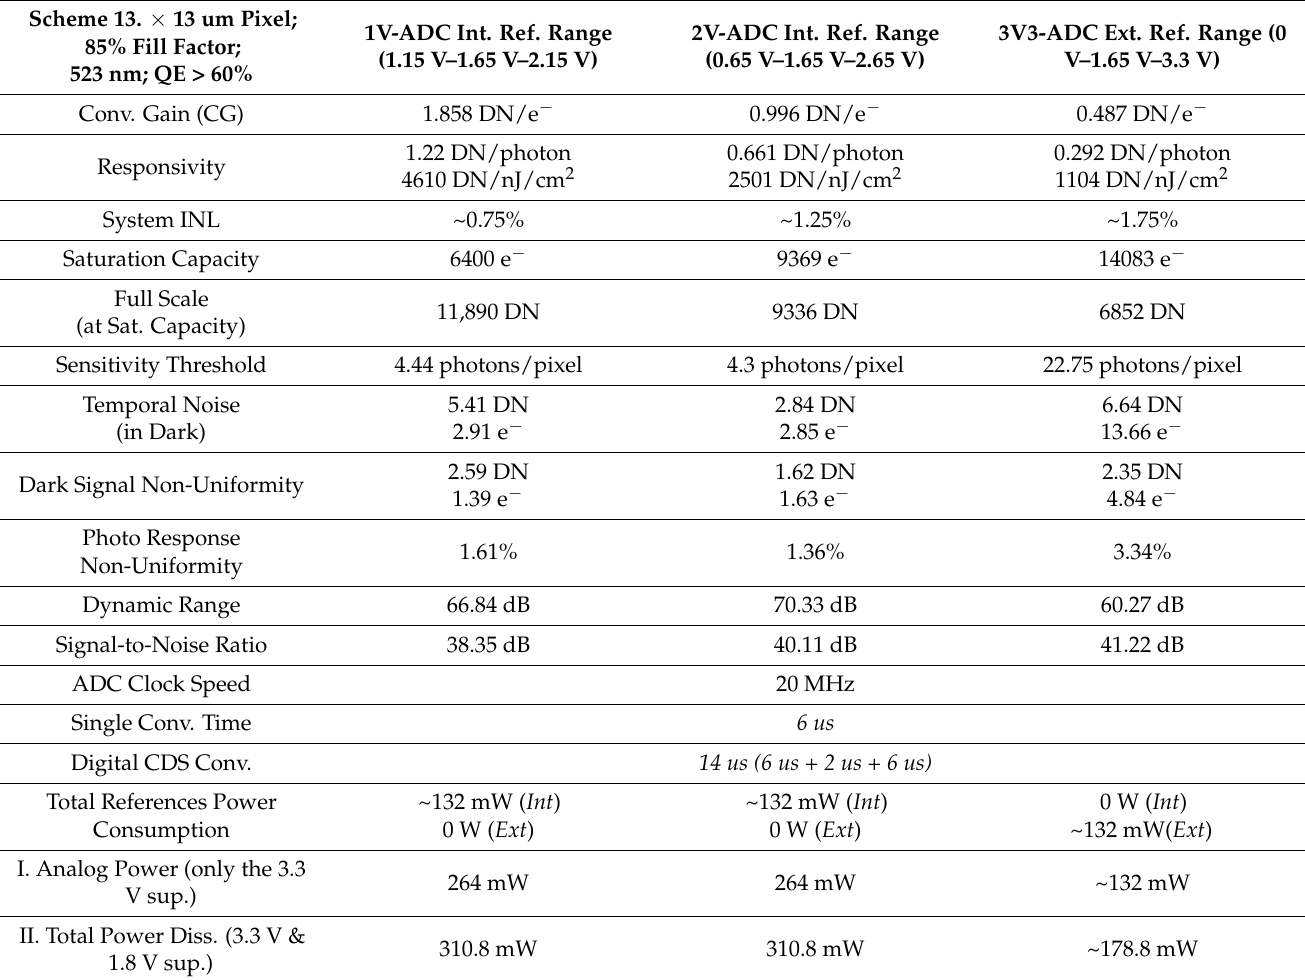
Table 1. Sensor key